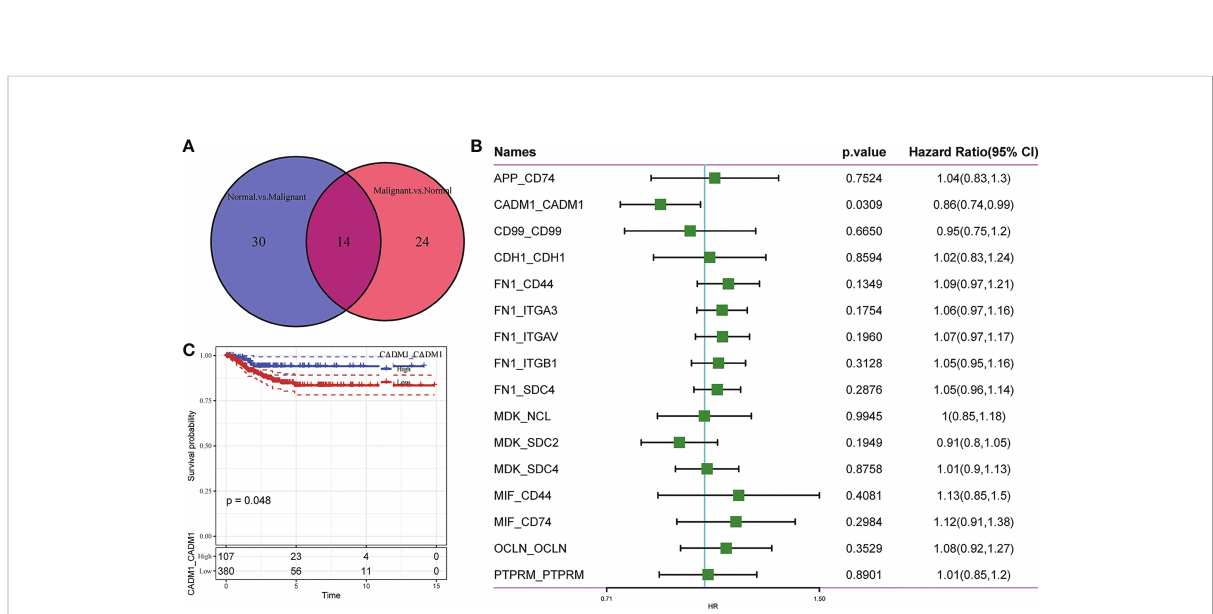
FIGURE 3 Screening of crucial L/R pairs. (A) Venn diagram of 38 L/R pairs communicating between malignant cells/non-malignant cells and 44 L/R pairs communicating between non-malignant cells/malignant cells. (B) Forest plot of univariate Cox regression analysis of 16 L/R pairs. (C) KM curves of CADM1-CADM1.